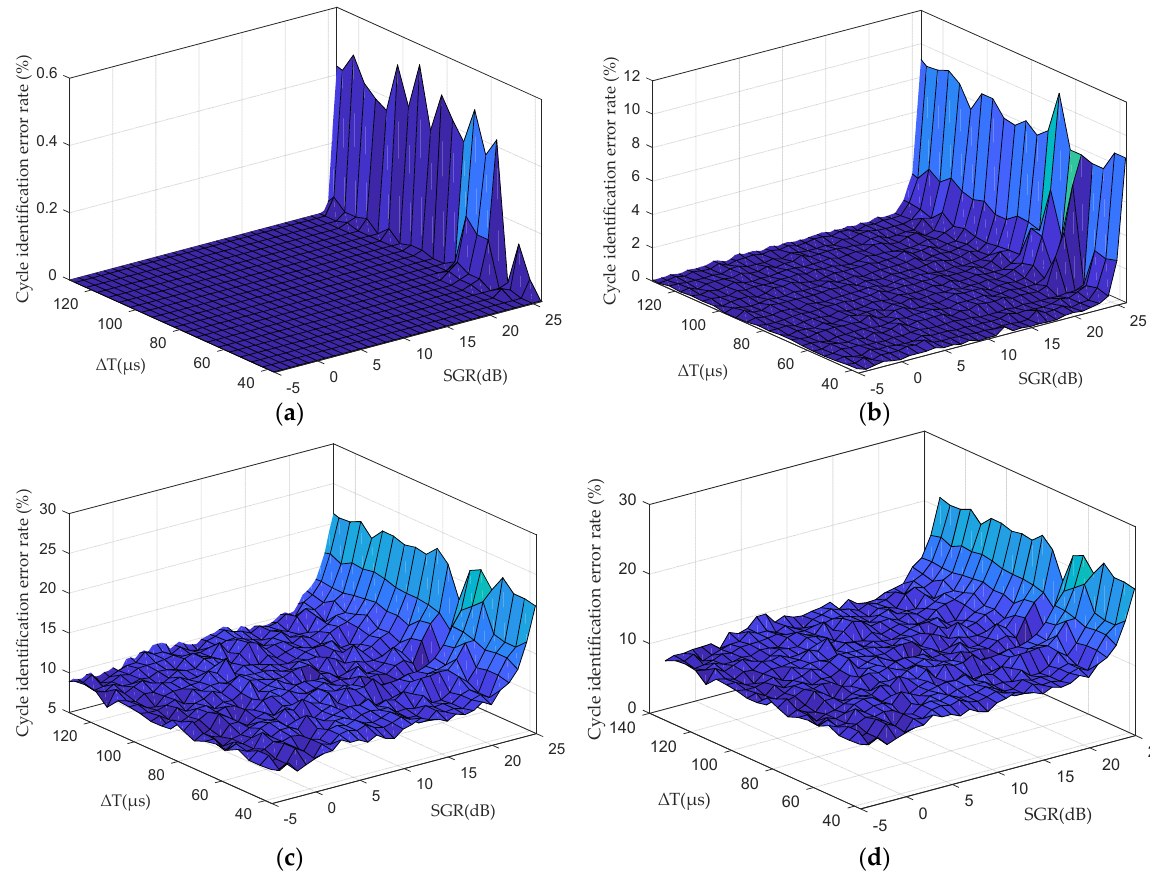
Figure 9. Performance simulation results of cycle identification method: ( a ) SNR = 0 dB; ( b ) SNR = − 5 dB; ( c ) SNR = − 10 dB; ( d ) SNR = − 13 dB.